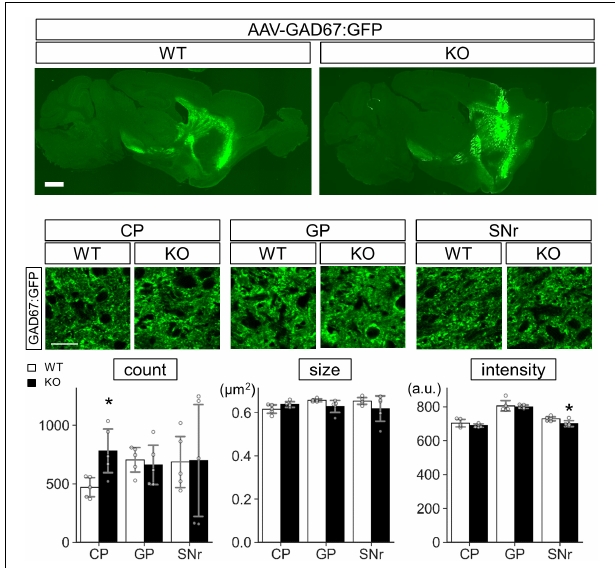
FIGURE 13 | GAD67:GFP is stacked in the cell body of Lrtm2 KO SPNs. GAD67: GFP expressing AAV is injected into the right dorsal striatum of Lrtm2 WT or KO mice. The distribution of GAD67:GFP was examined 12 days after injection. Top , representative GFP signal distribution in Lrtm2 WT or Lrtm2 KO mice ( n = 5, 4–25 M-old 1 male and 4 females for each genotype). Scale bars , 1-mm-thick; 10- µ m-thin. Bottom . Quantification of GFP signals in CP, GP, and SNr. Gray circles indicate individual values, which are the means of two sections per mouse. * p < 0.05 in Student’s -test. Error bars ,